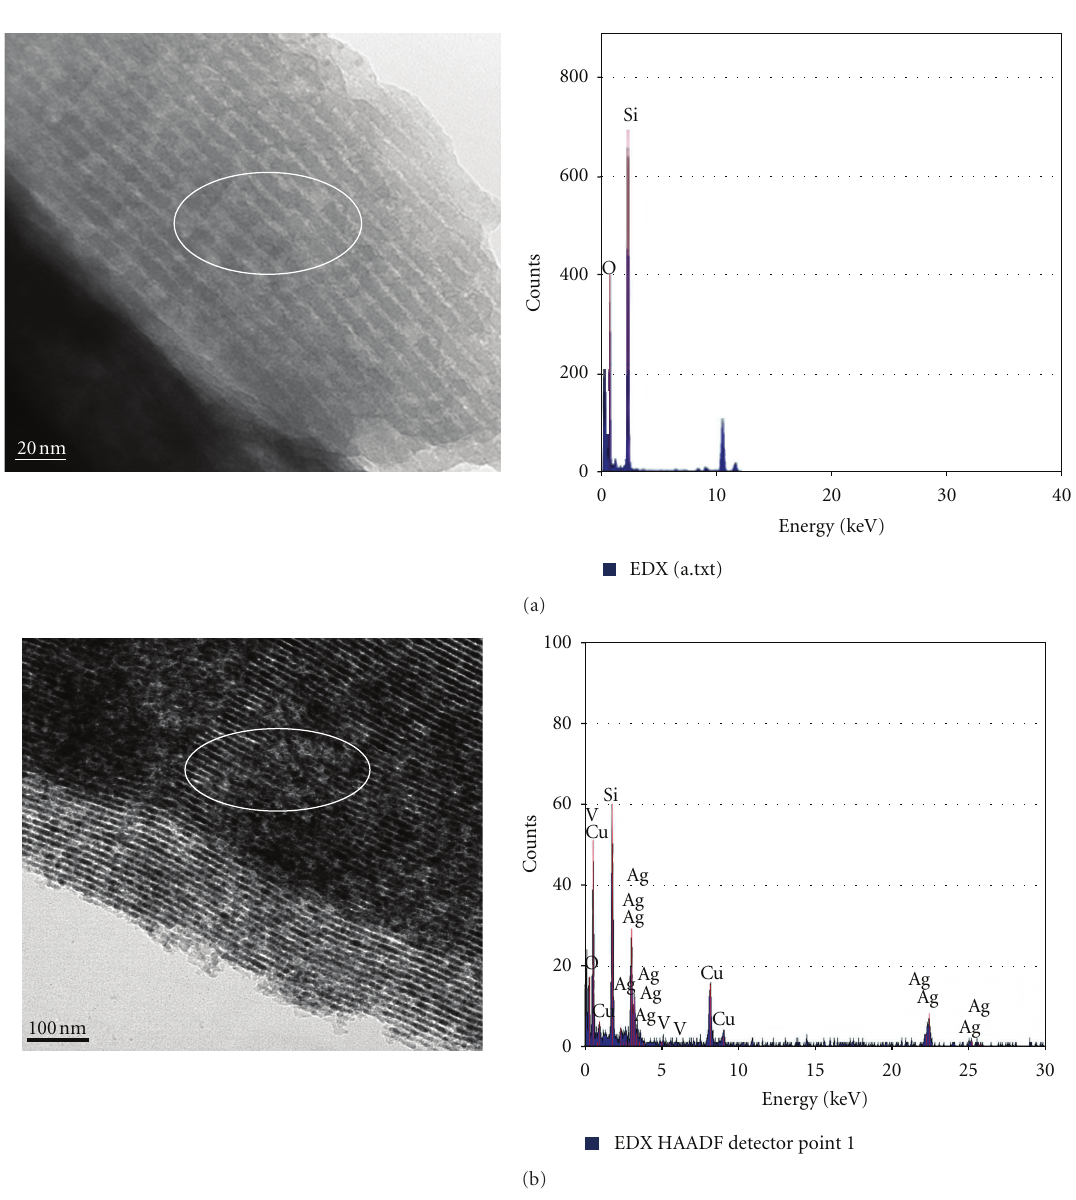
Figure 3: HRTEM images of (a) SBA-15 and (b)